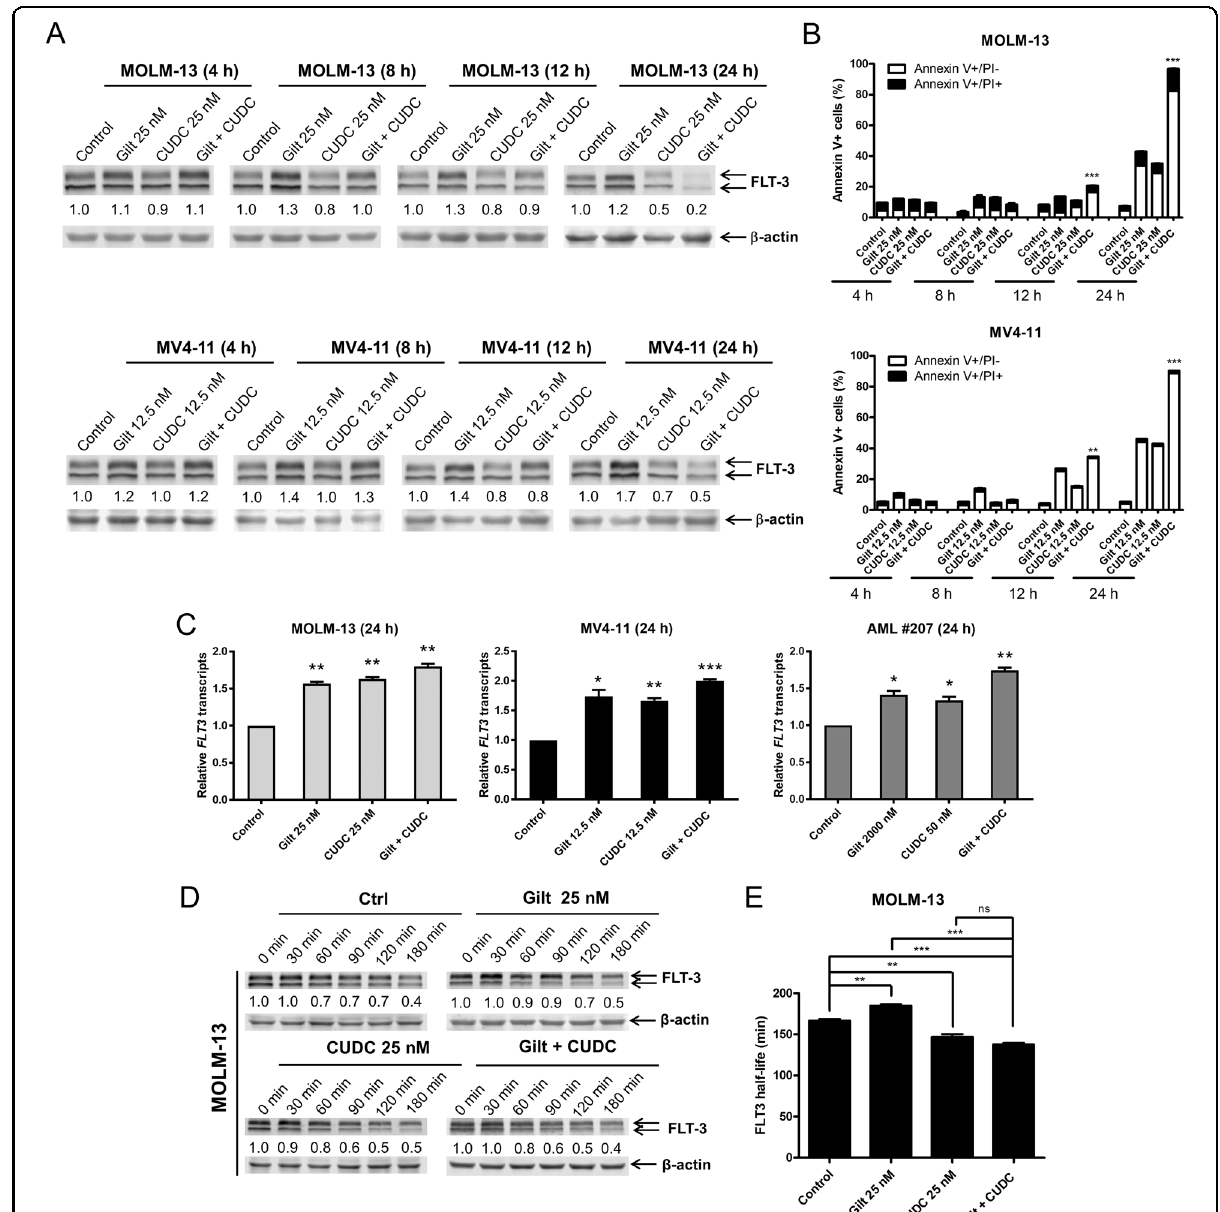
Fig. 4 Gilteritinib induces FLT3 upregulation, which is abrogated by CUDC-907. A FLT3-ITD AML cell lines MOLM-13 and MV4-11 were treated with gilteritinib, CUDC-907, both, or neither for 4, 8, 12, or 24 h, at concentrations of 12.5 or 25 nM, as indicated. Western blots were generated using whole-cell lysates. One representative blot is shown. Densitometry measurements, compared to vehicle control and normalized to β -actin, are shown below the corresponding blots. B MOLM-13 and MV4-11 cells were treated as described in panel A and then stained with annexin V/PI and subjected to fl ow cytometry analysis. ** p < 0.01 and *** p < 0.001 compared to single-drug treatments at the same timepoint. C MOLM-13, MV4-11, and primary FLT3-ITD positive AML patient sample AML#207 were treated with gilteritinib, CUDC-907, both, or vehicle control for 24 h at the indicated concentrations. Total RNA was extracted, and FLT3 transcripts relative to GAPDH were determined by real-time RT-PCR. * p < 0.05, ** p < 0.01, and *** p < 0.001 compared to vehicle control. D , E MOLM-13 cells were treated with CUDC-907 and/or gilteritinib for 12 h, washed, and then treated with cycloheximide for up to 3 h. Western blots were generated utilizing whole-cell lysates. The fold changes for the FLT3 densitometry were assessed via comparison to vehicle control and normalized to β -actin. Representative blots are shown in panel ( D ), while densitometry measurements are graphed in panel ( E ). ** p < 0.01, *** p < 0.001, and ns indicates not signi fi